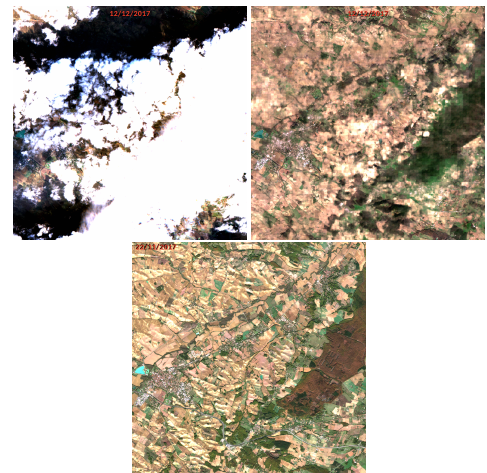
Figure 10. Limits of the SSOP networks with thick clouds in optical images. Top left: input cloudy optical image S 2 t , Top right: SSOP network output (cid:100) S 2 t . Bottom: the reference image S 2 t (cid:48) .